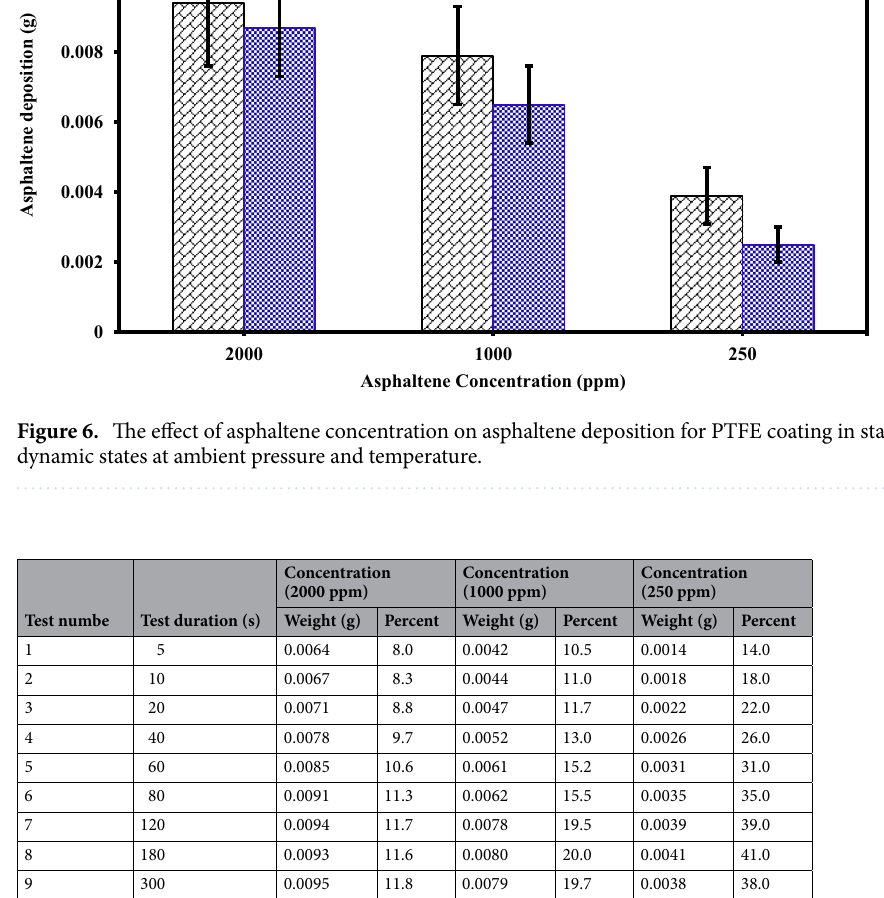
Table 7. Asphaltene deposition rate on PTFE coated electrode in static state for different asphaltene concentrations and exposure time to electric filed. Deposition value (electric field strength 2 kV/cm, 4% toluene concentration, PTFE coating, static state).